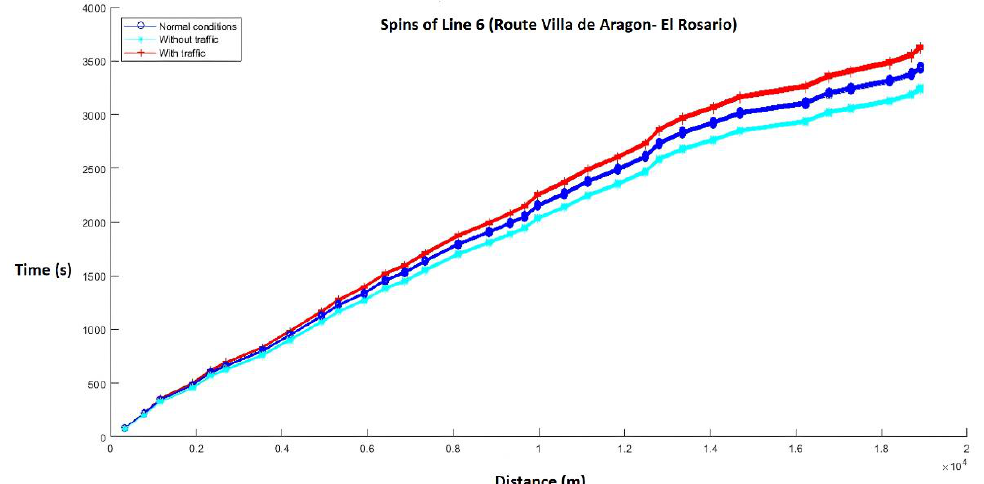
Figure 9. Relationship of the distance traveled vs. the traffic density of each segment that makes up Line 6.